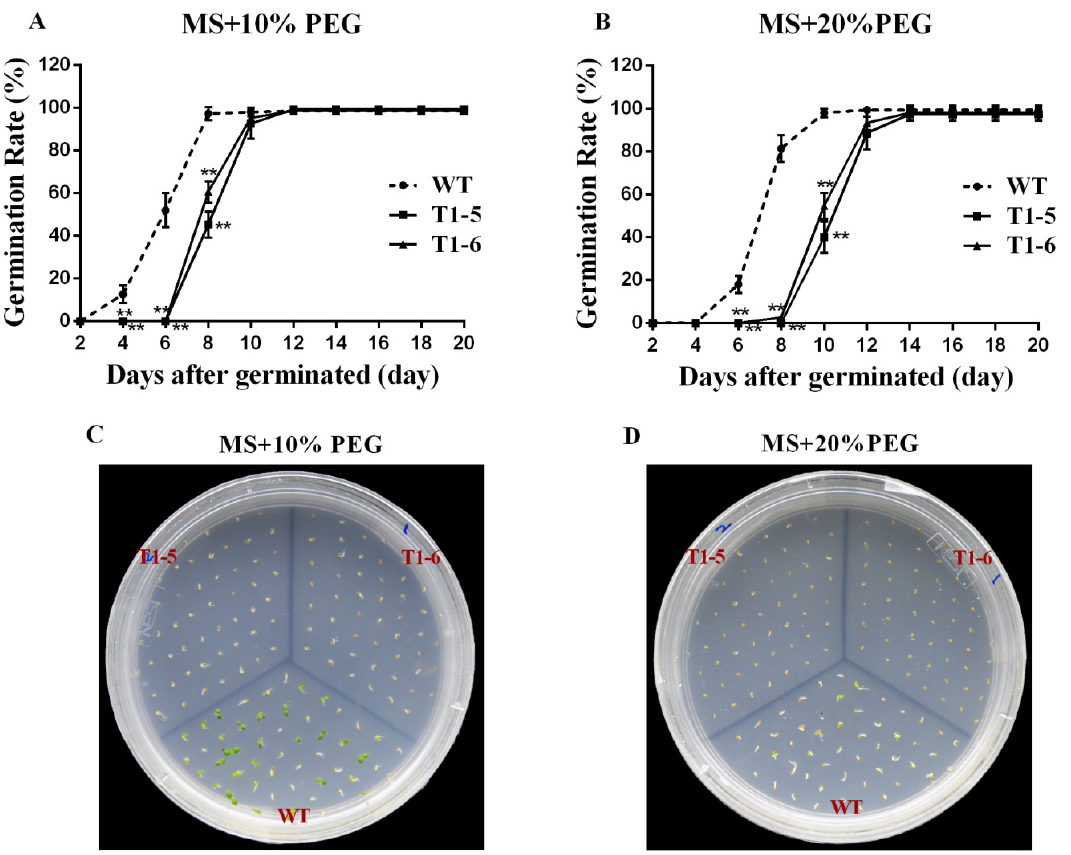
Figure 8. E ff ects of PEG application on germination rates between wild-type (WT) and transgenic plants. Fifty seeds of WT and T1 transgenic plants were sown on sterile MS solid medium supplemented with di ff erent concentrations of PEG ( A , B ). Values are means ± SD ( n = 3). The photographs ( C , D ) were taken after being sown for 9 days. * and ** Significant at p < 0.05 and p < 0.01 compared with WT, respectively.